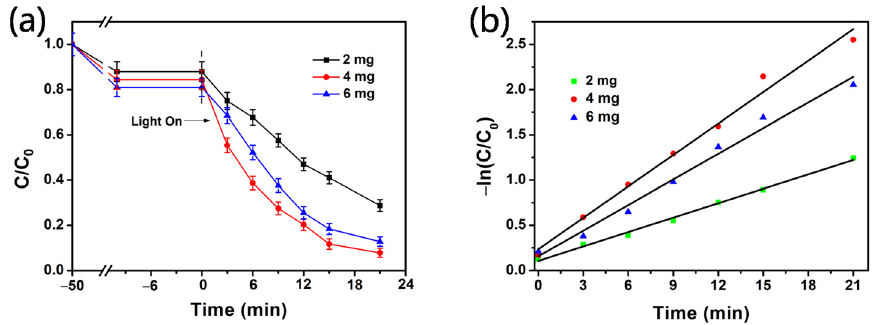
Figure 4. ( a ) Effect of Ag@mTiO 2 dosage on photocatalytic degradation of MB. ( b ) Kinetic plots of − ln(C/C 0 ) versus time.